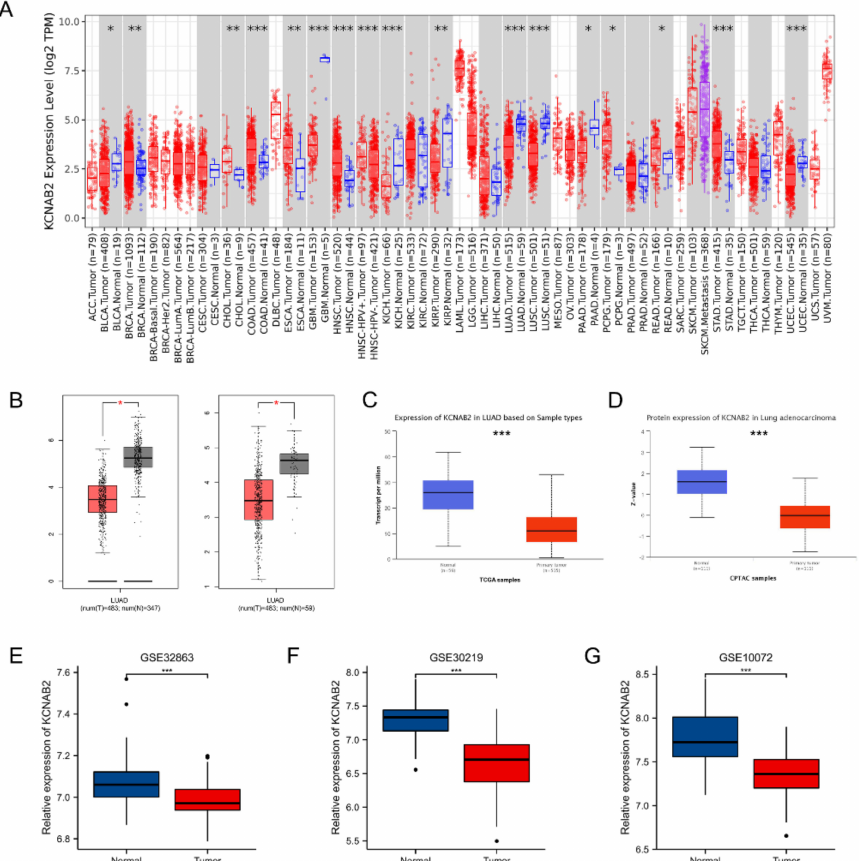
Figure 1. Expression of KCNAB2 in LUAD. ( A ) KCNAB2 expression levels in different tumor tissues were detected using TIMER. ( B ) Decreased expression of KCNAB2 was investigated in the GEPIA database. ( C ) The mRNA and ( D ) protein expression of KCNAB2 in LUAD were examined in the UALCAN database. ( E – G ) KCNAB2 mRNA expression levels were validated by GEO datasets. * p < 0.05, ** p < 0.01, *** p <